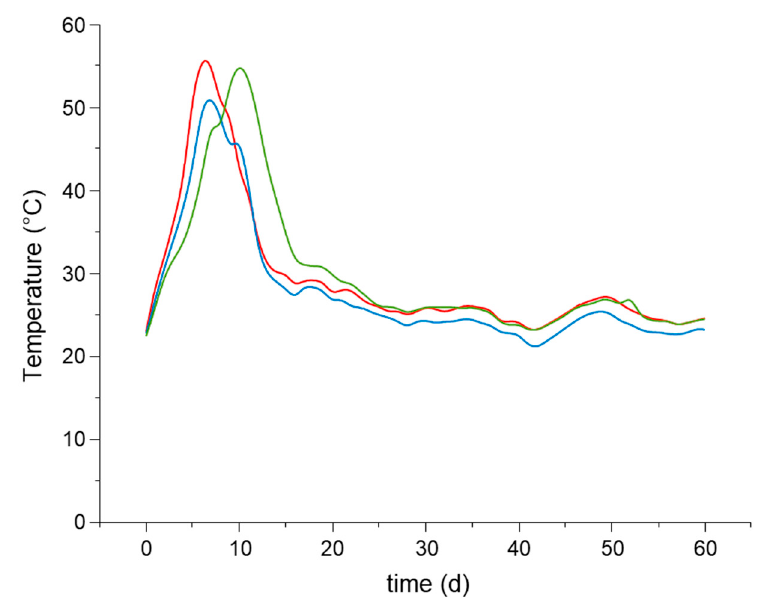
Figure 4. Temperature evolution for 6% (red line), 8% (blue line) and 10% (green line) addition of grits along the composting process.